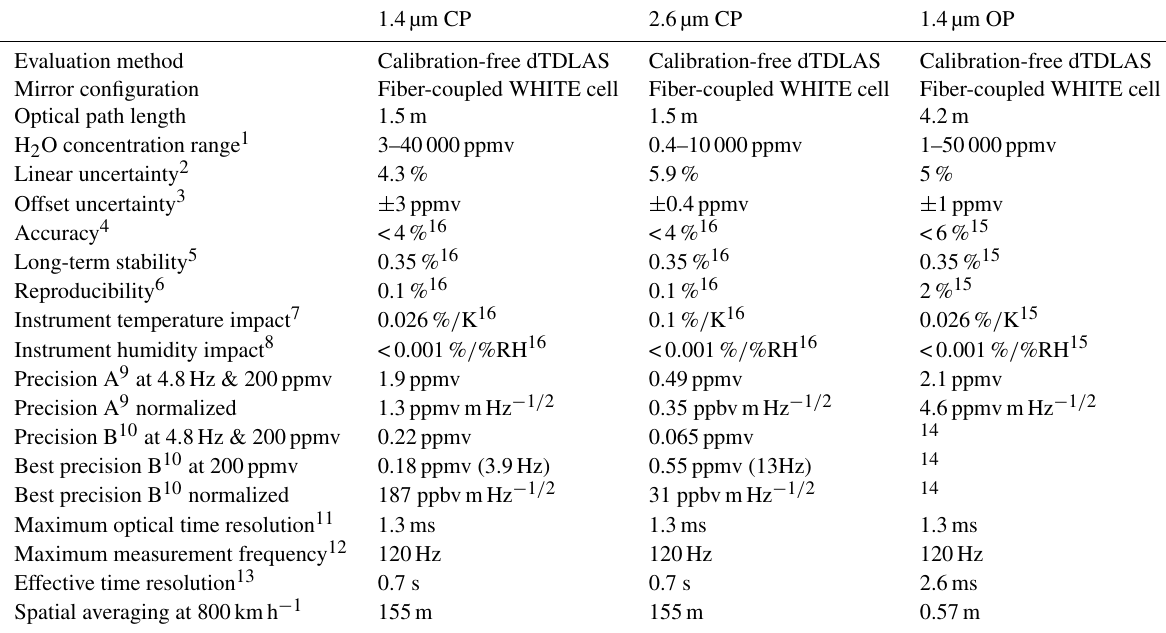
Table 1. Performance overview of HAI: 1 lower limit is defined by offset uncertainty and the upper limit by instrument temperature or spectroscopic effects; 2 calculated uncertainty based on calibration-free evaluation model; 3 calculated based on the accuracy level of the independent parasitic absorption minimization and determination (Buchholz and Ebert, 2014b); 4 general statements for typical airborne application; 4 , 5 , 6 , 7 , 8 statements based on several metrological method validations which are not part of this paper; 9 precision derived from single absorption signal as described in paper; 10 precision derived from Allan variance approach; 11 depending on broadening of the absorption line, the maximum time resolution variates between 1 and 2ms; 12 HAI reports 120 independent measurements per second; 13 the effective time resolution is limited for the closed-path cell by the gas flow rate (exchange rate) and for the open-path cell by an minimum average number of two raw spectra to save SSD space; 14 the Allan variance is not a feasible approach for retrieving reliable in- flight statements; 15 these open-path figures are inferred from closed-path measurements, and a direct metrological validation is not viable; 16 figures are based on a variety of studies which will be published in individual, coherent